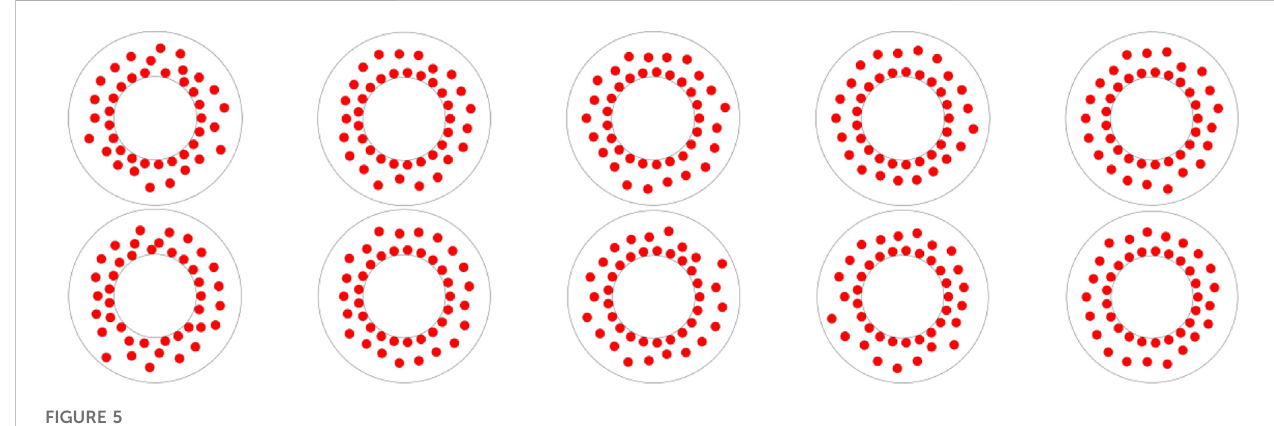
FIGURE 5 WOA to optimize the AWCC layout.